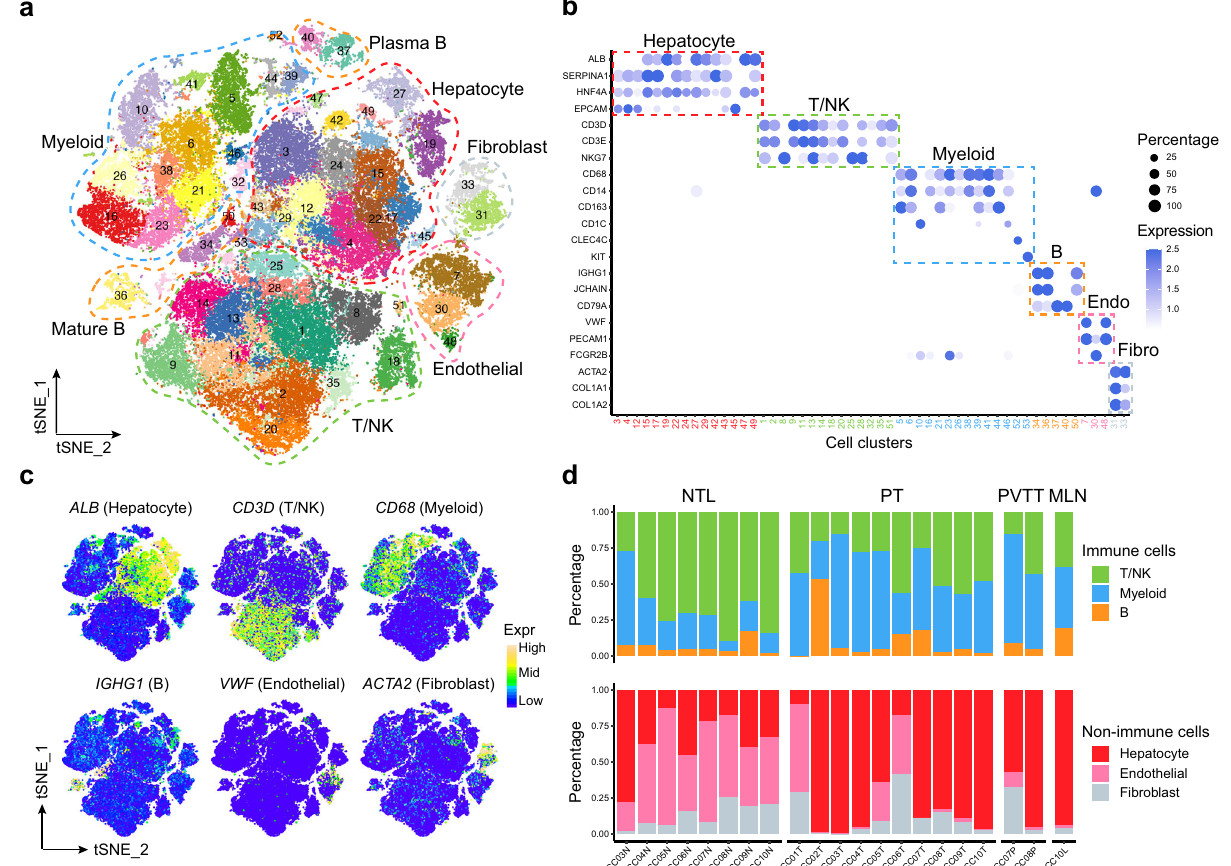
Fig. 1 | scRNA-seq pro fi ling of multicellular ecosystem in primary and meta- static HCC and non-tumor liver tissues. a The T-distributed Stochastic Neighbor Embedding (tSNE) plot of 53 cell clusters from the multicellular ecosystem of 10 HCC patients. Cells from different clusters are marked by colors. Major cell types are marked by dashed lines. b Dotplot showing the percentage of expressed cells and average expression levels of canonical marker genes of major cell types in 53 cell clusters. Endo Endothelial, Fibro Fibroblast. c The tSNE plots showing the